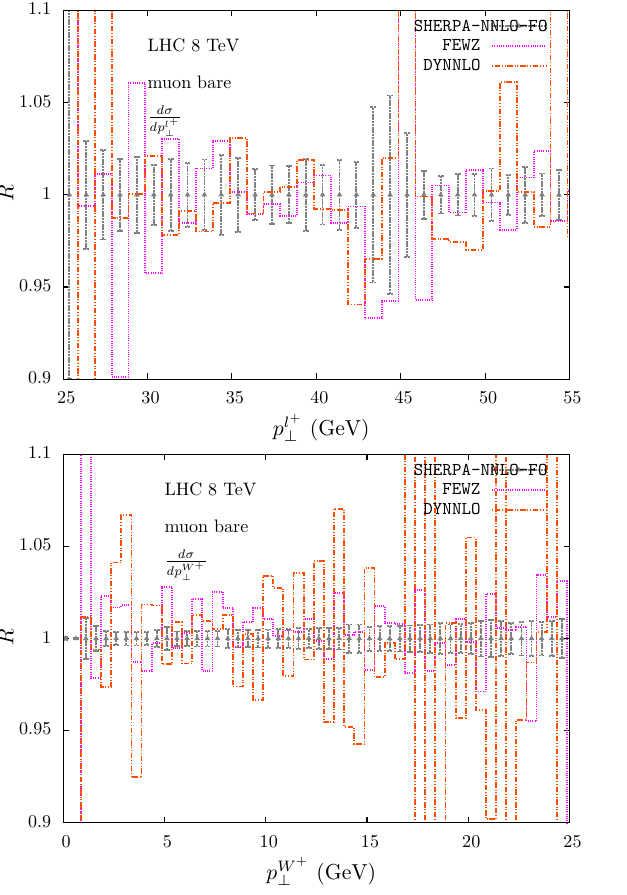
Fig. 16 Comparison of NNLO QCD predictions by DYNNLO , FEWZ and SHERPA-NNLO-FO for pp → γ, Z → μ + μ − + X . Comparison of the lepton transverse momentum ( upper left ), lepton-